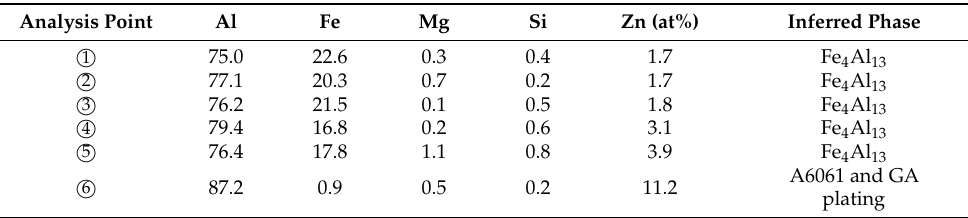
Table 1. Quantitative analysis results for the analysis points shown in Figure 7b.